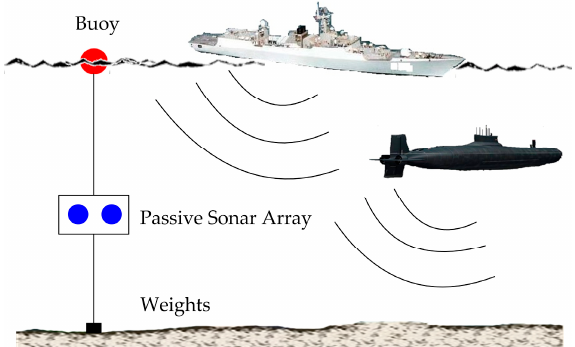
Figure 1. Passive sonar array composed of two hydrophones suspended in water at a certain depth by using the buoy and weights, and applied to acoustic signal acquisition of moving targets on or under water surface. Under the influence of Doppler generated by relative motion of the moving target and the passive sonar array, the received acoustic signals emitted from the target become non-stationary and time-varying. In this case, there must be significant errors between the true values of target detection or localization and the estimation results obtained by the methods based on stationary signal hypothesis.